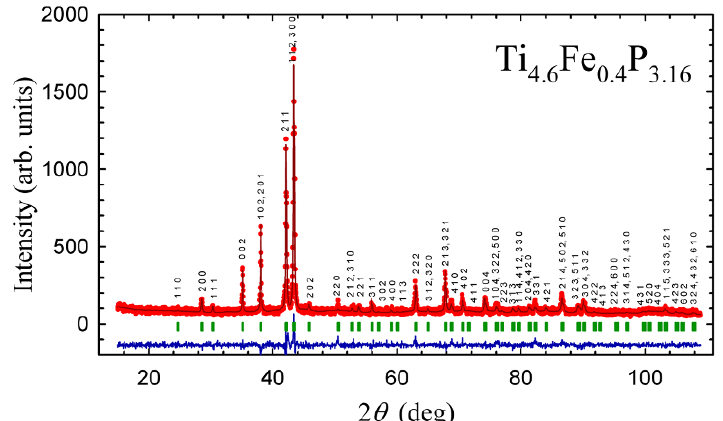
Figure 2. Observed ( ۰ ) calculated (-) and difference X-ray diffraction patterns of the Ti